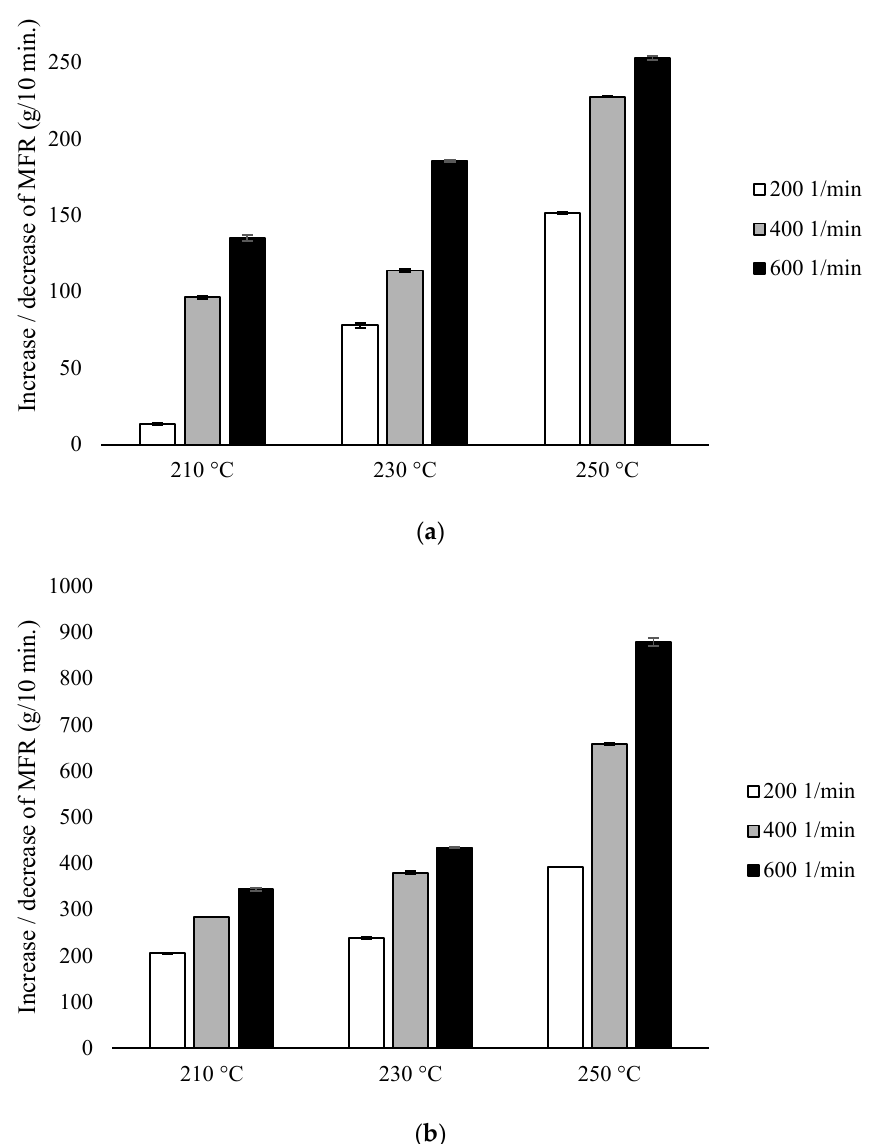
Figure 2. Melt Flow Rate (MFR), difference % with non-extruded PLA: ( a ) configuration 1; ( b ) configuration 2. Abbreviations: as in Table 1.